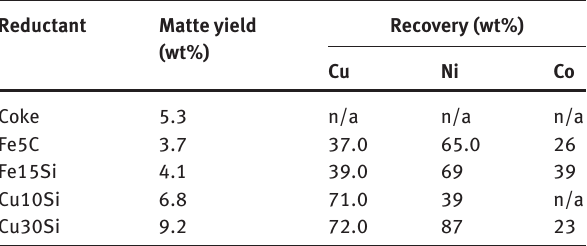
Table 3: Overall matte yield from the copper smelter slag and valuable metals recovery.